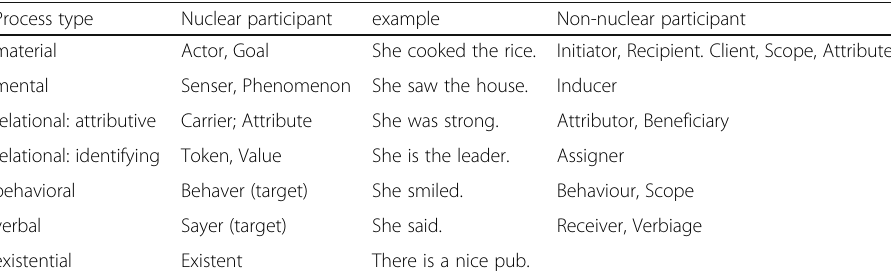
Table 3 Participants in systemic functional linguistics Process